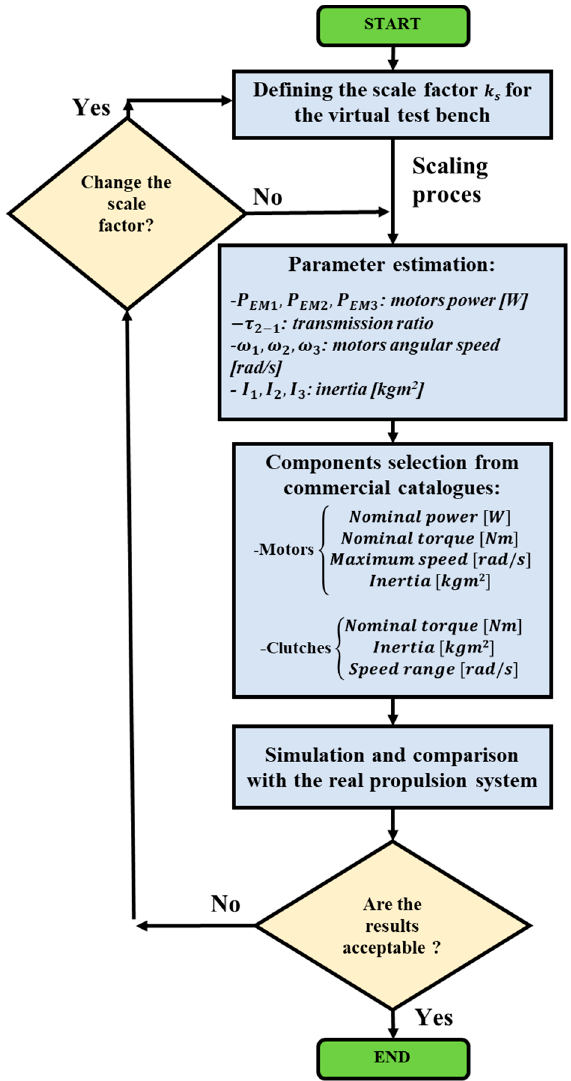
Figure 5. Flow chart of the scaling process.